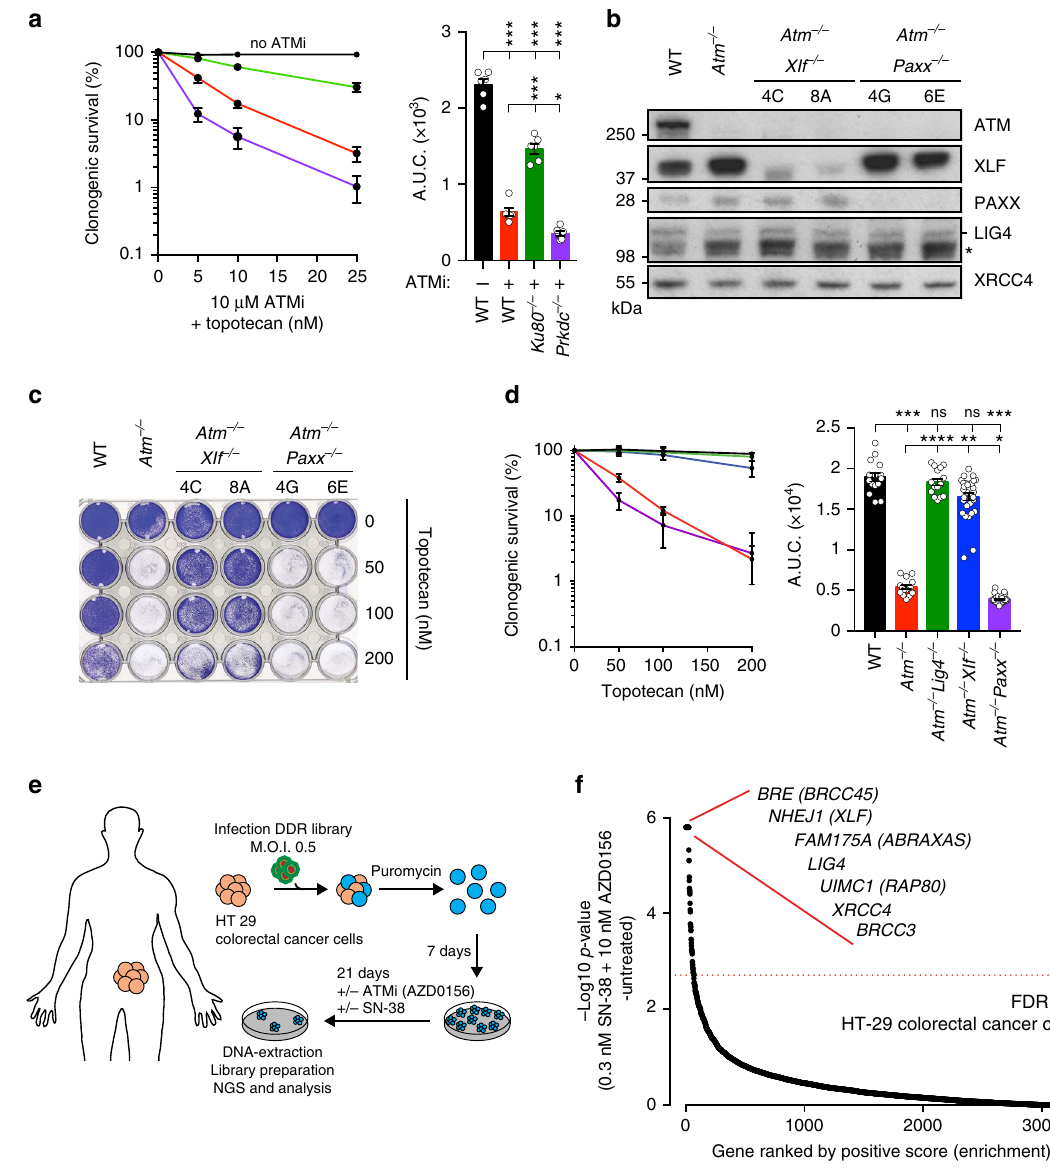
Fig. 4 Only certain NHEJ factors are involved in topotecan resistance in ATM-de fi cient cells. a Quanti fi cation of clonogenic survival assays showing that inhibiting ATM kinase activity sensitizes WT cells to topotecan and that inactivation of Xrcc5/Ku80 but not Prkdc/DNA-PKcs partially suppresses this phenotype. n = 9/genotype. b Representative immunoblot images depicting abundance of ATM, XLF, and PAXX proteins in Atm − / − Xlf − / − and Atm − / − Paxx − / − cells as compared to WT and Atm − / − cells. LIG4 (- indicates LIG4, while * indicates an antibody cross-reacting protein) and XRCC4 was used as loading controls. c Crystal violet cell viability assay showing that loss of XLF but not of PAXX ameliorates the hypersensitivity of ATM-de fi cient cells to topotecan. d Quanti fi cation of clonogenic survival assays indicating that the hypersensitivity of Atm − / − cells to topotecan is alleviated in Atm − / − Xlf − / − but not in Atm − / − Paxx − / − cells (WT and Atm − / − Lig4 − / − cells used as controls). n = 15/genotype. e Outline of the CRISPR screen in cancer cells. HT-29 colorectal cancer cells were infected with lentiviral particles containing a DDR focused sgRNA library, subjected to puromycin selection, and passaged to ensure loss of affected protein products. Puromycin-resistant cells were exposed to 10 nM ATMi (AZD0156) and 0.3 nM Irinotecan (SN-38) for 21 days, and resistant pools were isolated. MOI multiplicity of infection. f Classi fi cation of the most enriched CRISPR-targeted genes. Dotted red lines represent positive enrichment false discovery rate (FDR) thresholds. Represented are the names of top hits with highest enrichment scores. All data were analyzed by using MAGeCK and are available in Supplementary Data fi le 5. Images are representative of three individual experiments; individual clone names are represented below the genotypes. a , d containing clonogenic survival assays (left) and AUCs (right) were generated by using GraphPad Prism 7. Bars represent mean ± s.e.m.; **** p < 0.0001; *** p < 0.001; ** p < 0.01; * p < 0.05; NS = not signi fi cant ( p > 0.05); two-tailed Student ’ s